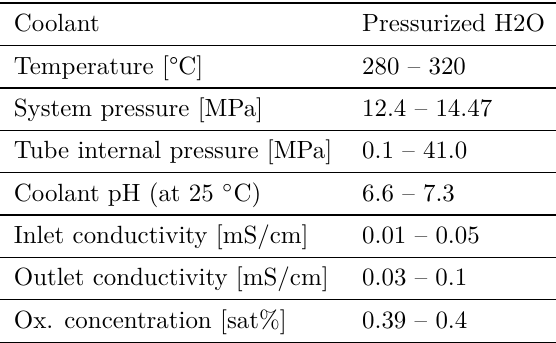
Table 1. Experimental parameters for autoclave coolant.